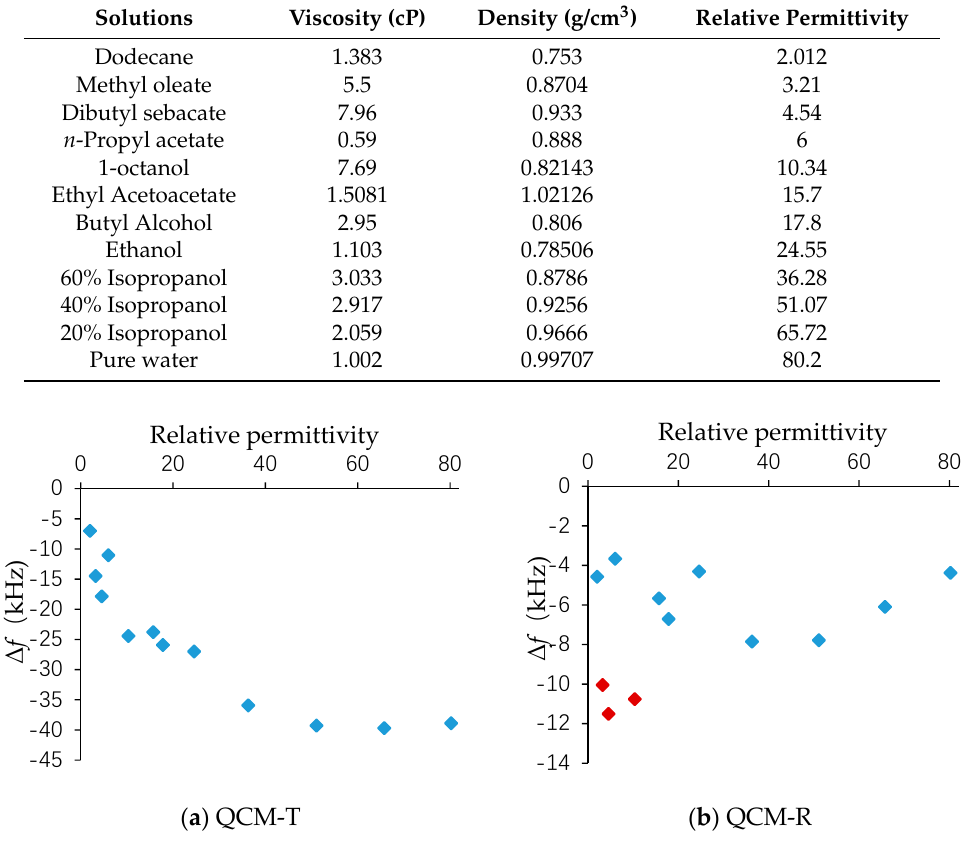
Figure 6. Measured frequency shift difference on the liquid relative permittivity.